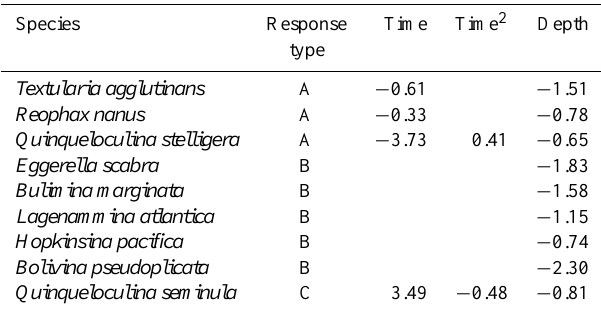
Table 5. Estimation of the coefficient associated with independent variables after model-type 2 for the nine major species. Only the in- dependent variables having a significant effect on the standing stock are retained by the backward model selection. Depending on the presence or absence of a significant effect of time on the density and the coefficient sign, three types of responses have been deter-